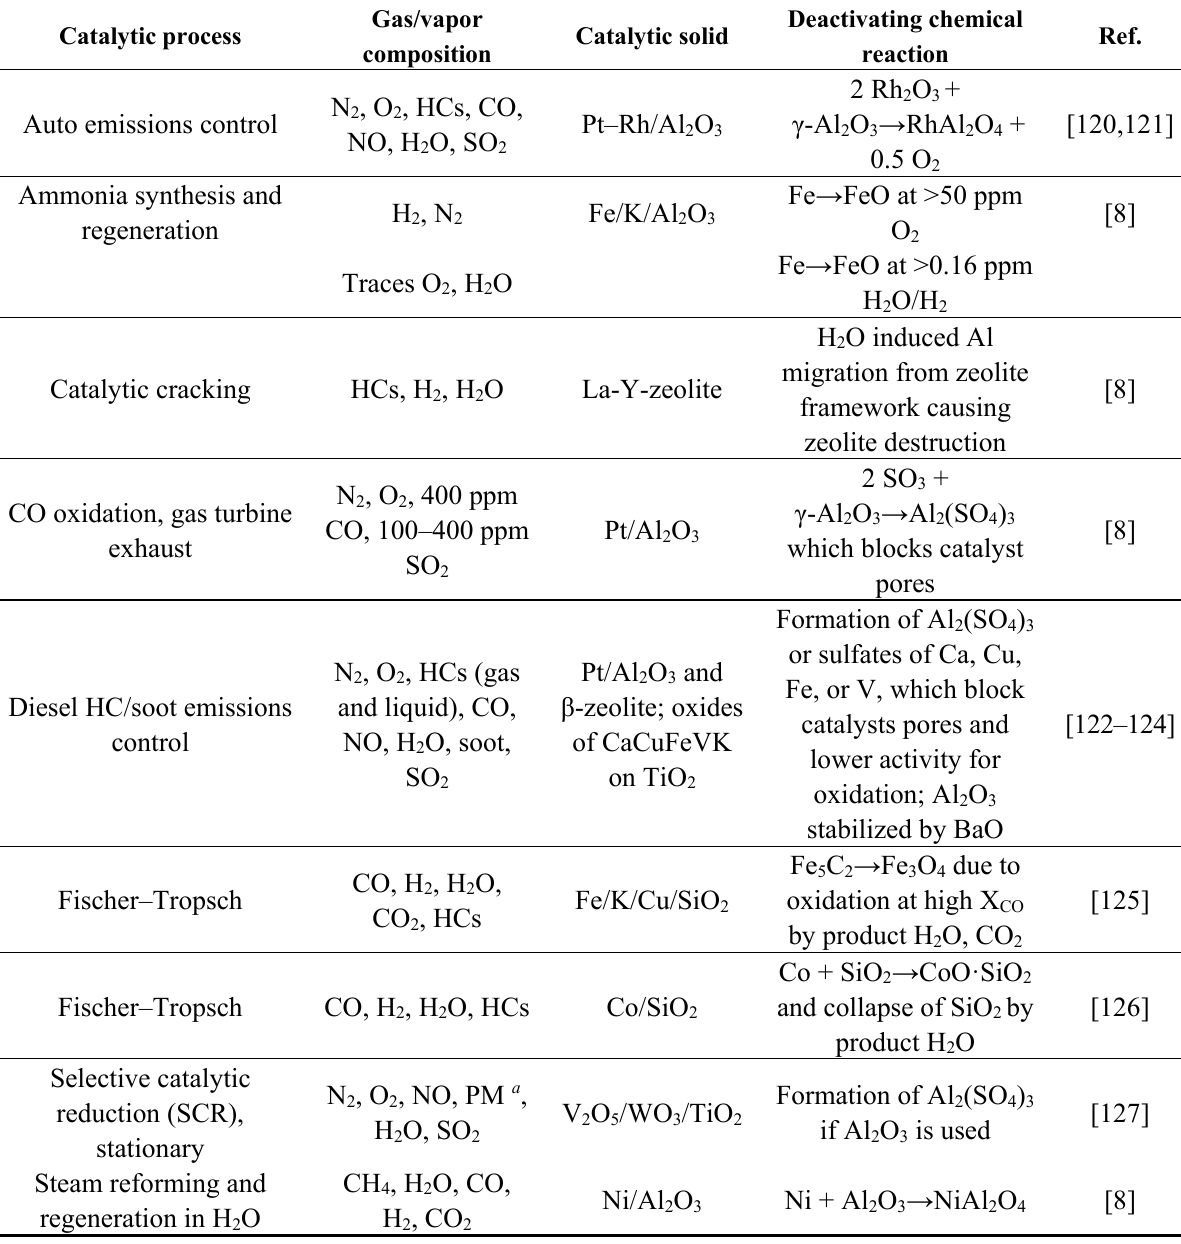
Table 11. Examples of Reactions of Gases/Vapors with Catalytic Solids to Produce Inactive Phases.